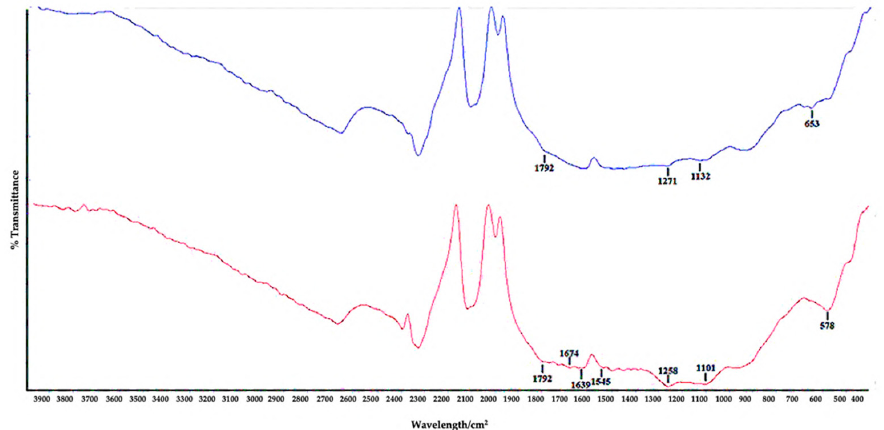
Figure 3. FTIR spectra of the original GO (blue), and EDC/NHS activated GO (red).